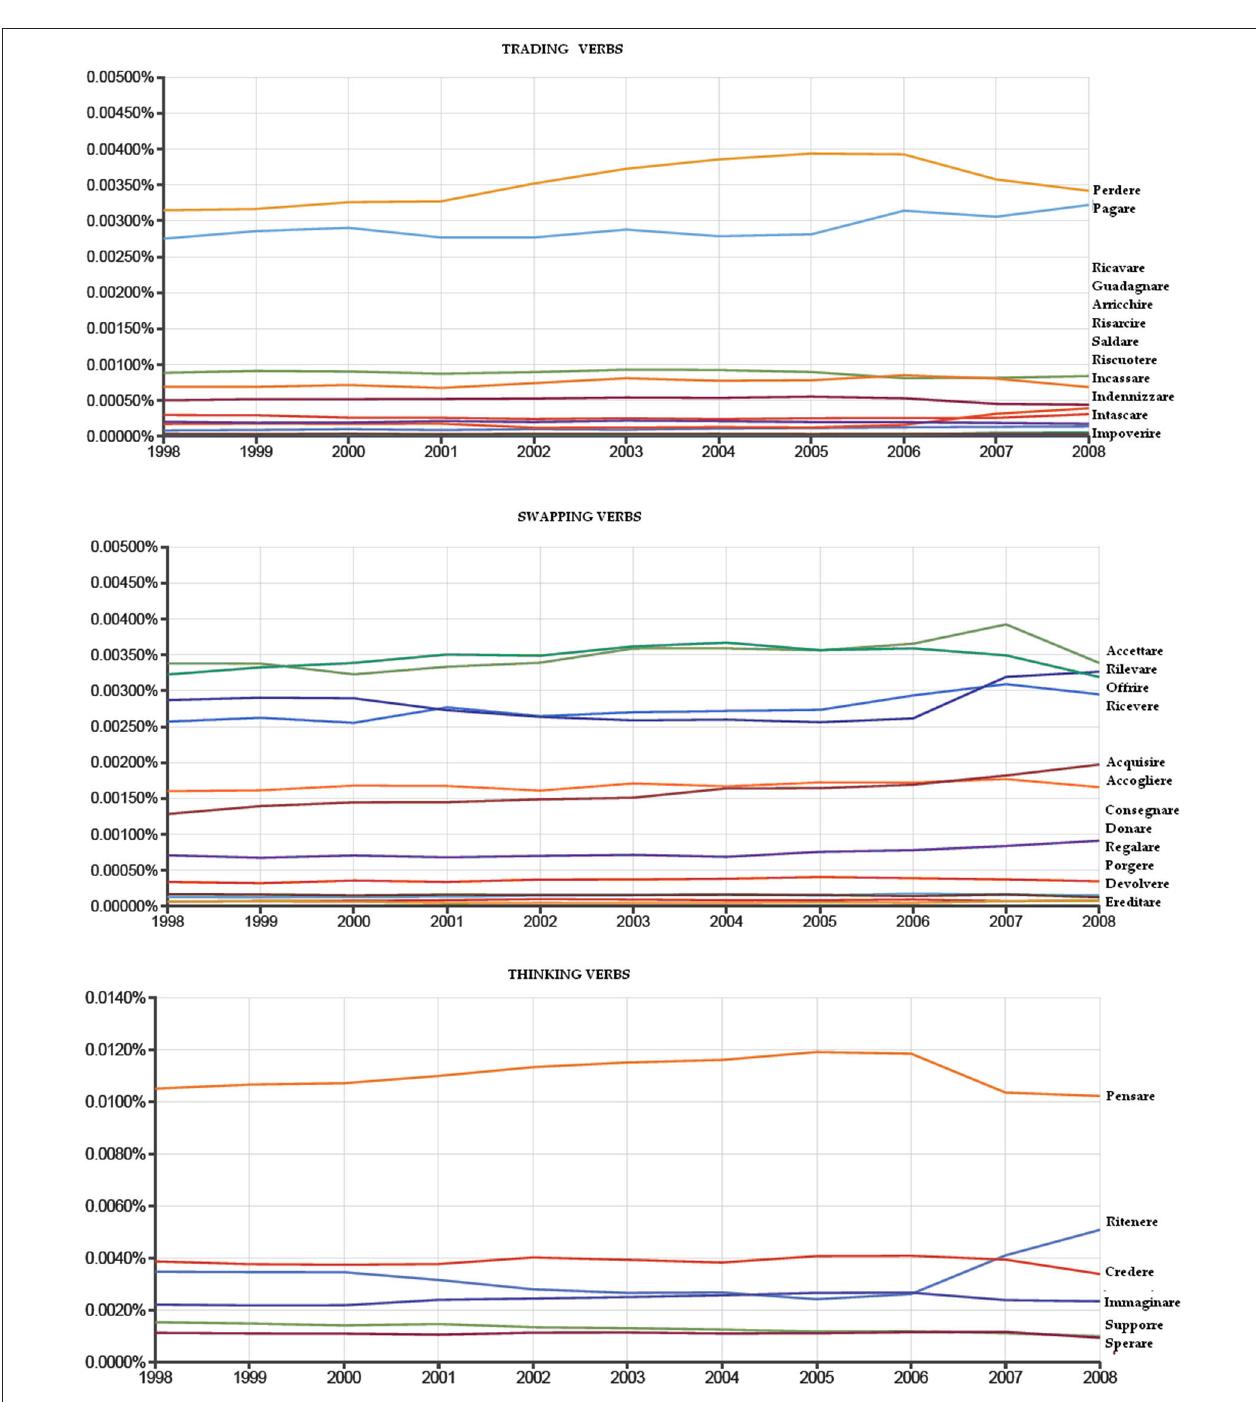
FIGURE 2 | Google Ngram viewer outputs for the three verb categories . From top to down this figure show the output % provided by google Ngram viewer for Trading, Swapping and Thinking verbs from 1998 to 2008.